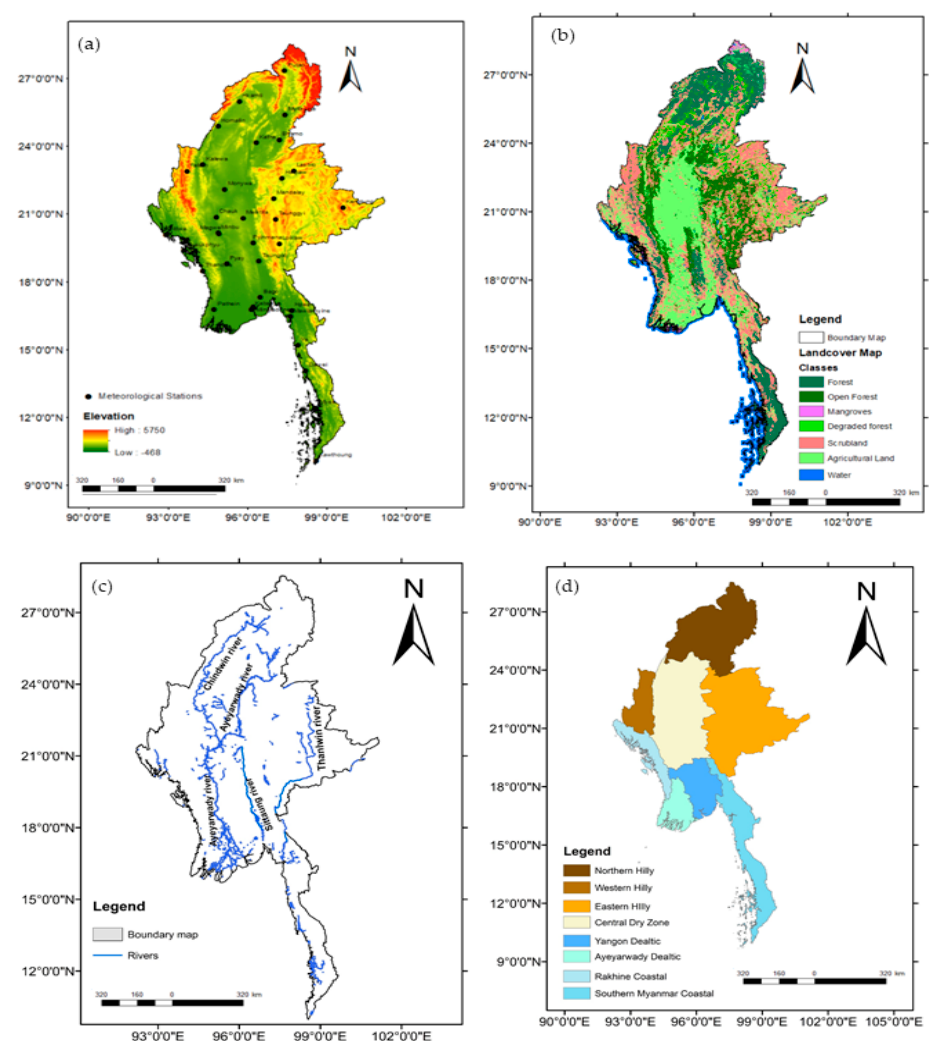
Figure 1. Geoinformation of Myanmar. ( a ) Land surface elevation (m) and meteorological station locations; ( b ) landcover map [58] ; ( c ) major rivers [58] ; and ( d ) eco-physiographic zones [59] .